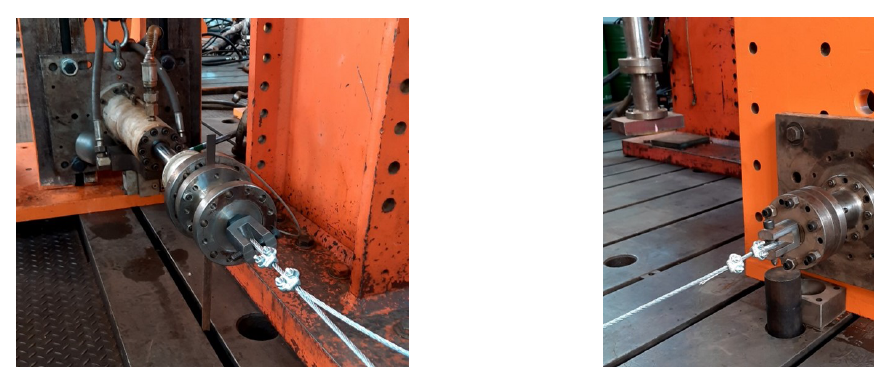
Figure 3. Details of the cable end fixings. Table 1. Loads applied to the mockup tower